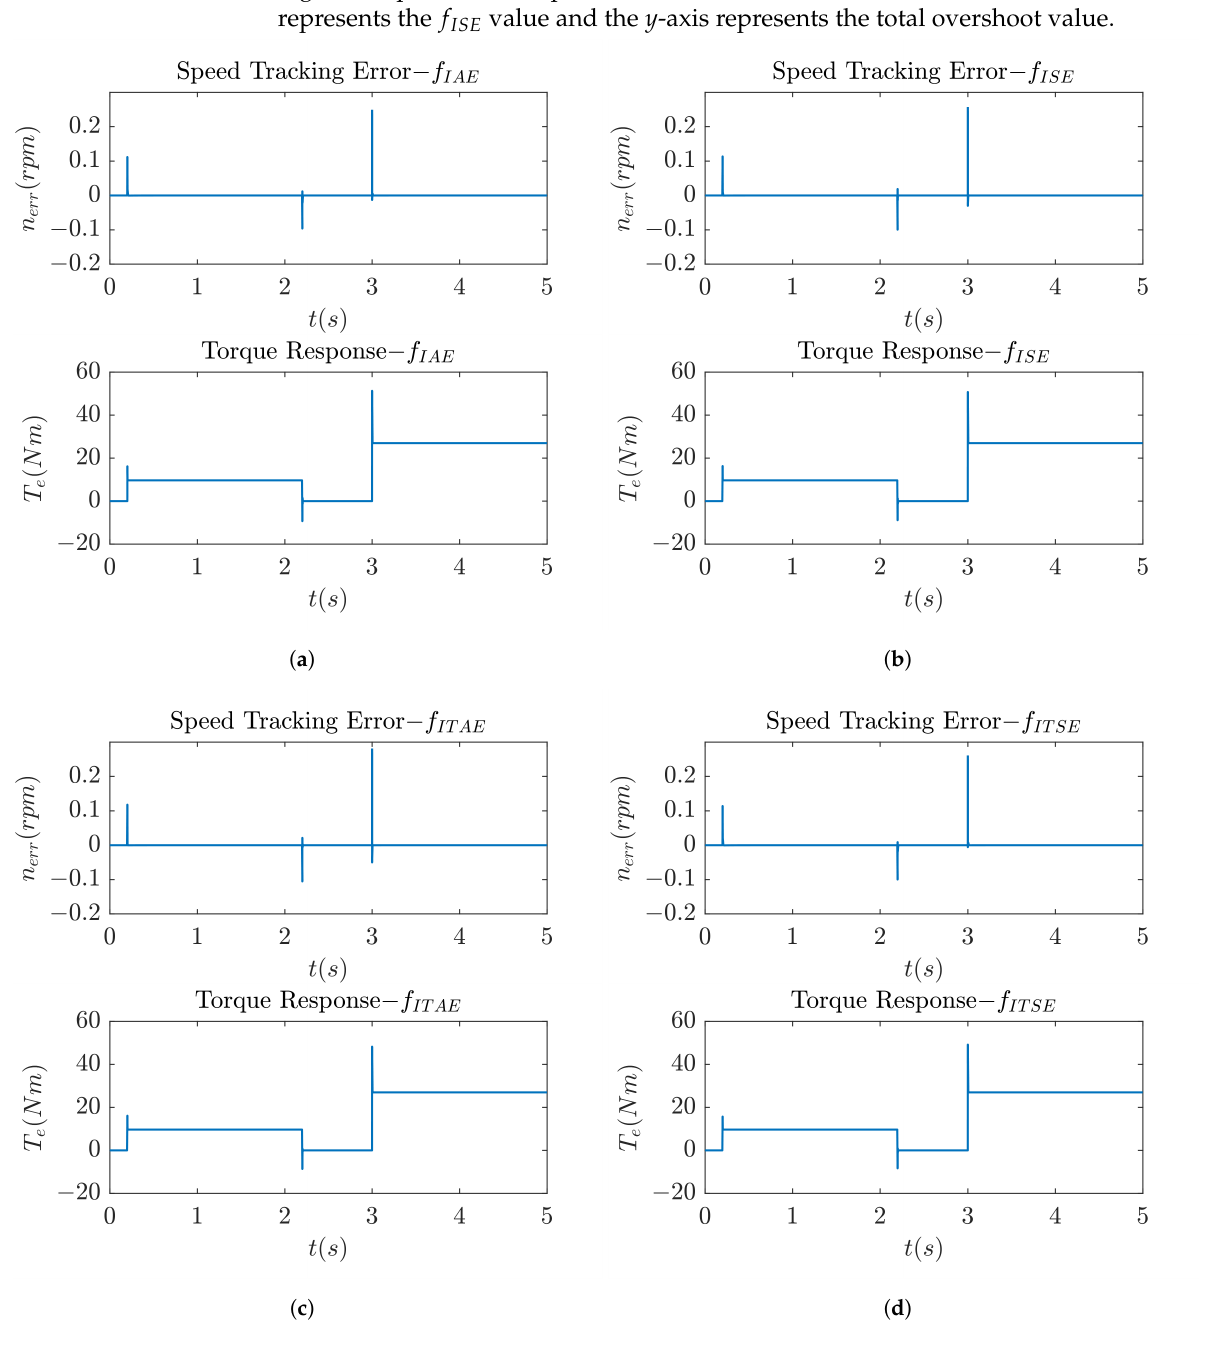
Figure 7. Speed tracking error and torque responses produced by: ( a ) Integral absolute error criterion. ( b ) Integral squared error criterion. ( c ) Integral time absolute error criterion. ( d ) Integral time squared error